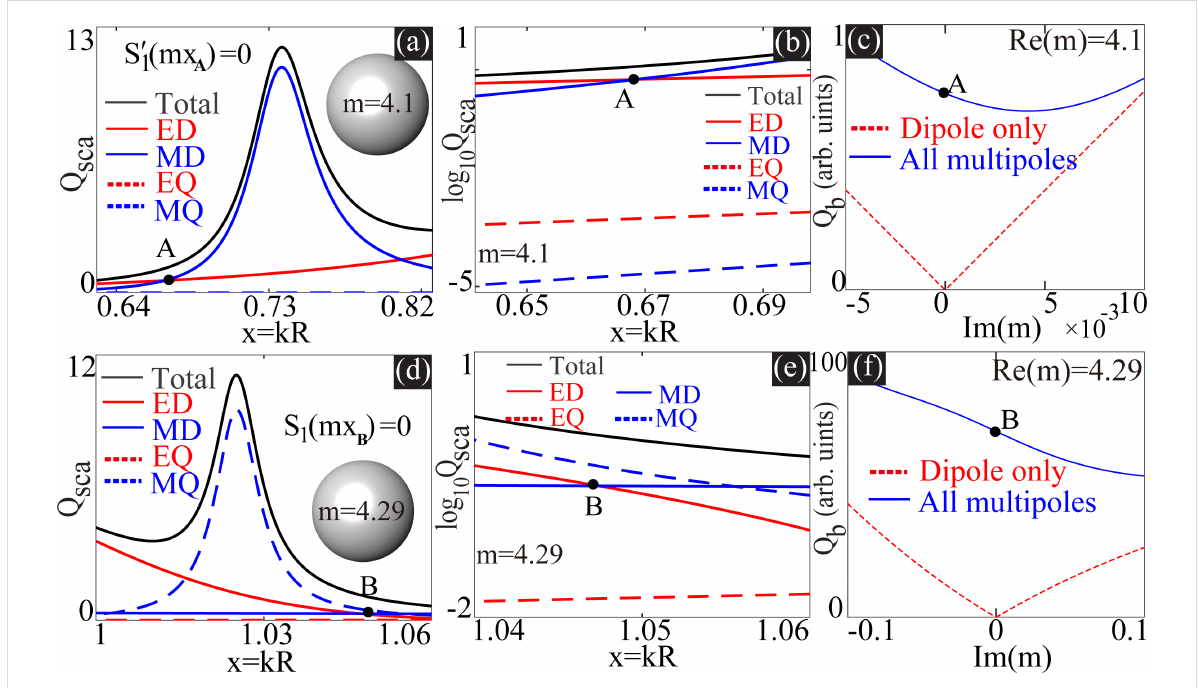
Figure 1: Scattering spectra (both total scattering and the contributions from different multipoles are included) are shown in (a) and (b) for m = 4.1, and in (d) and (e) for m = 4.29. Here, (b) and (e) are sections of (a) and (b), respectively, which are close to the dipole matching points and enlarged for clarity. For each scenario, there is a indicated point ( x A ≈ 0.6684 and x B ≈ 1.0472) where the dipoles are perfectly matched. (c, f) Dependence of Q b on Im( m ), at x A with fixed Re( m ) = 4.1 and at x B with fixed Re( m ) = 4.29, respectively. In (c) and (f), two sets of results are shown, considering only dipoles or all multipoles,